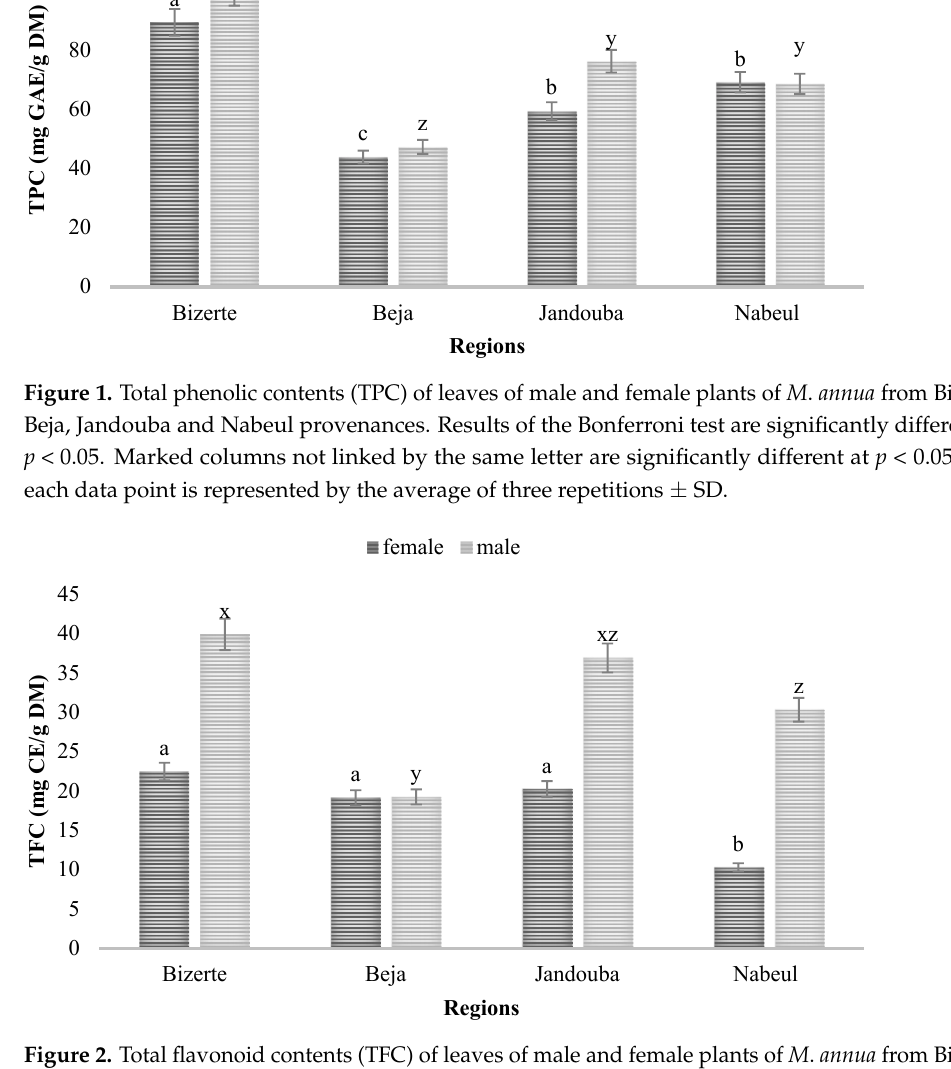
Figure 2. Total flavonoid contents (TFC) of leaves of male and female plants of M . annua from Bizerte, Beja, Jandouba and Nabeul provenances. Results of the Bonferroni test are significantly different at p < 0.05. Marked columns not linked by the same letter are significantly different at p < 0.05, and each data point is represented by the average of three repetitions ± SD.